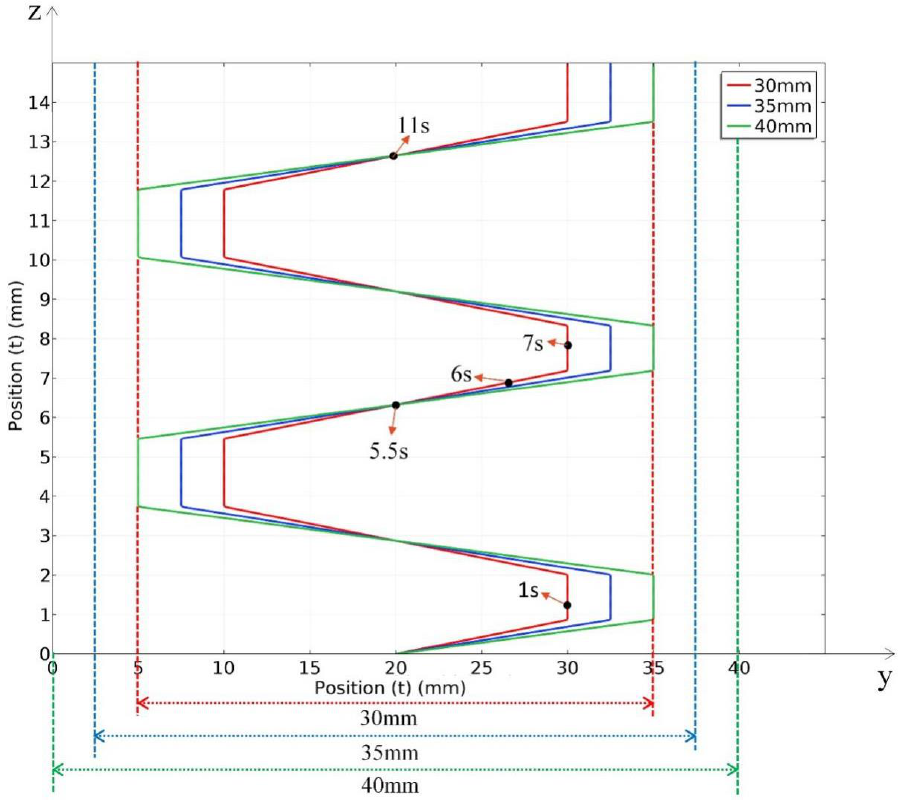
Figure 8. Movement path of oscillate-stop for thickness of 30 mm, 35 mm and 40 mm.